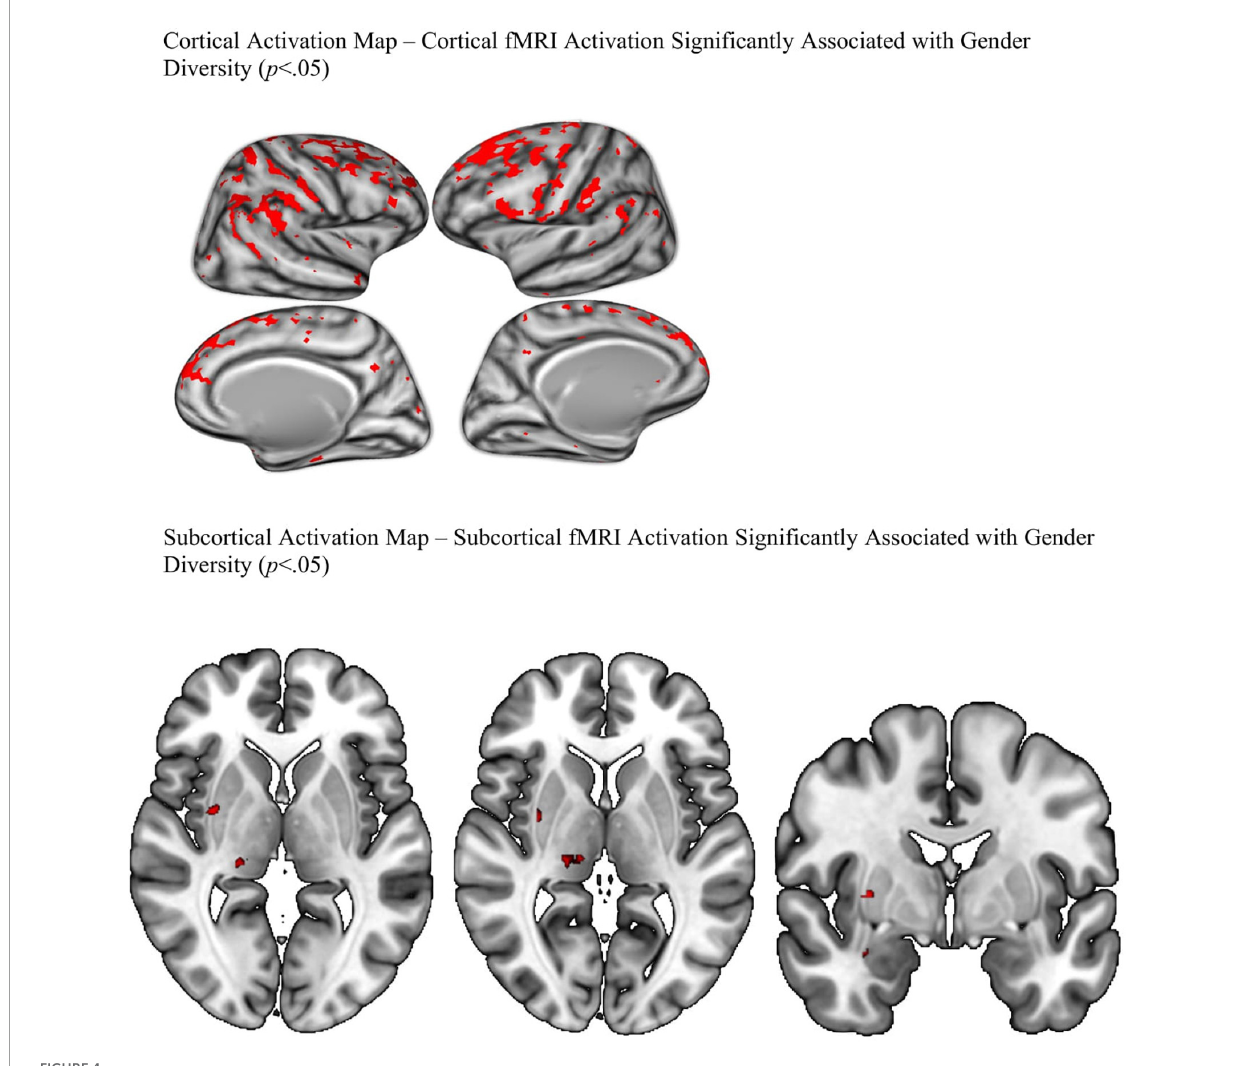
FIGURE4 FDR corrected P -value